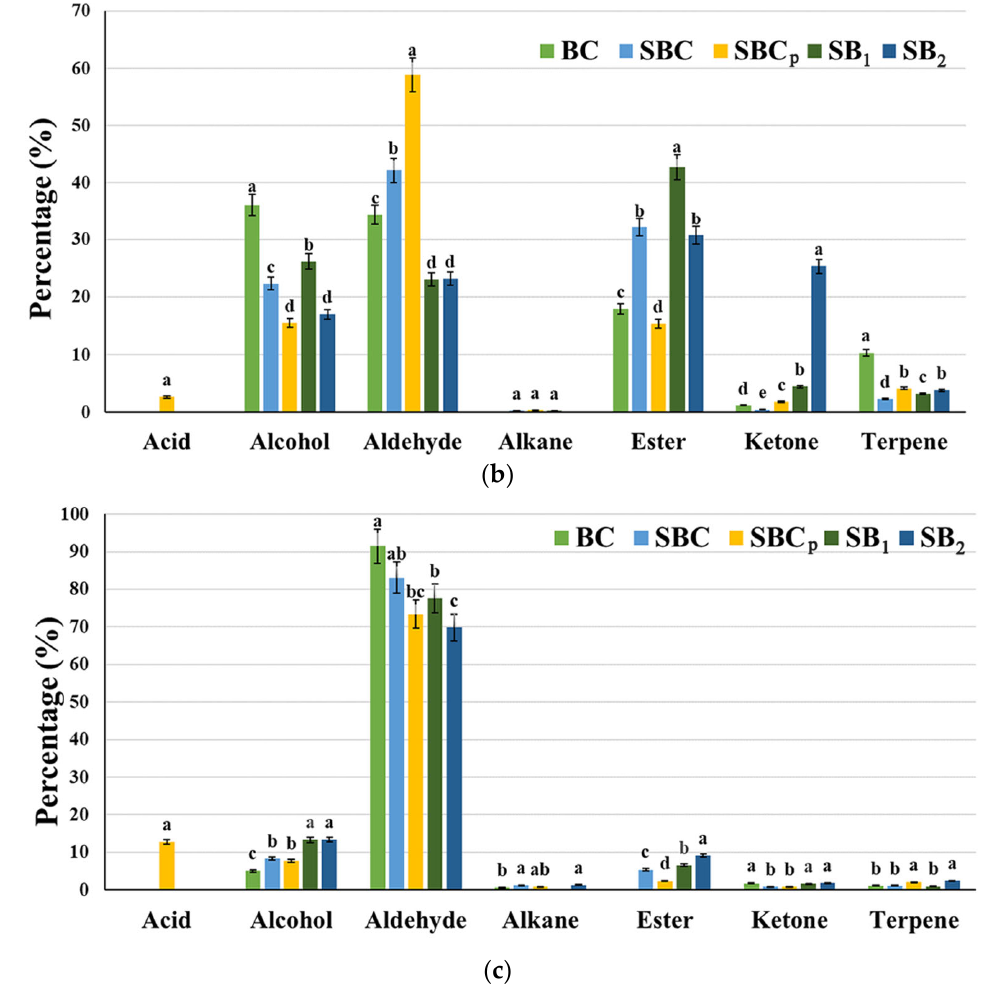
Figure 3. The relative percentage of volatile organic compounds. ( a ): doughs at T0; ( b ): fermented doughs; ( c ): baked breads. BC: bread control; SBC: sourdough bread control; SBC p : sourdough bread control with propionate; SB 1 : sourdough bread with L. plantarum 5L1 inoculum (0.5%); SB 2 : sourdough bread with L. plantarum 5L1 inoculum (5%). Different lower ‐ case letters indicate a significant difference in compound concentrations between treatments ( p ≥ 0.05).